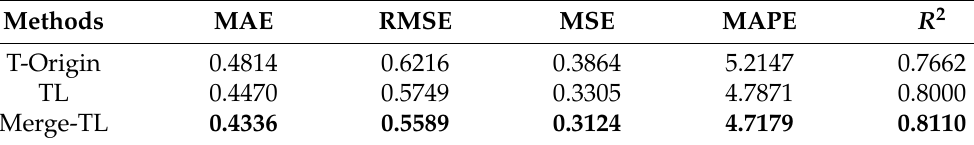
Table 4. The ablation experimental results of the 2 h prediction for S7.